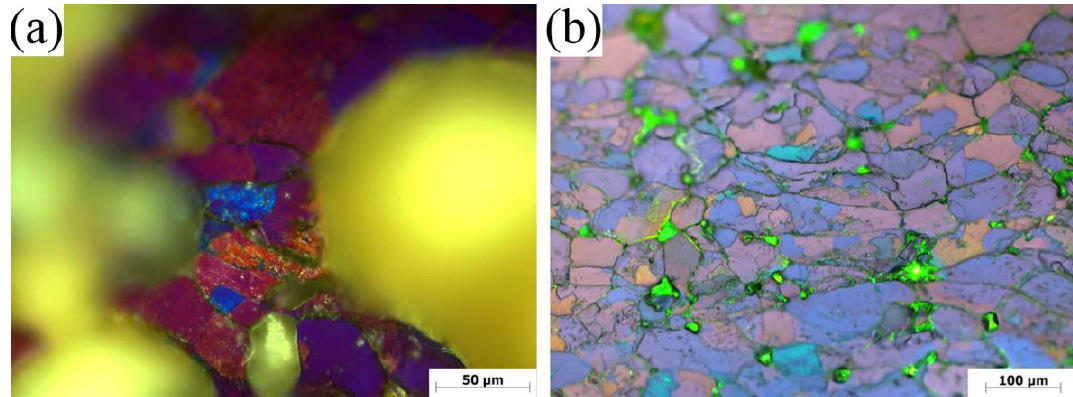
Figure 7. The microstructure of Zn/HA ( a ) pure zinc ( b ) in polarized light. Pores are colored in yellow and green. Individual grains are visible inside individual zinc particles.